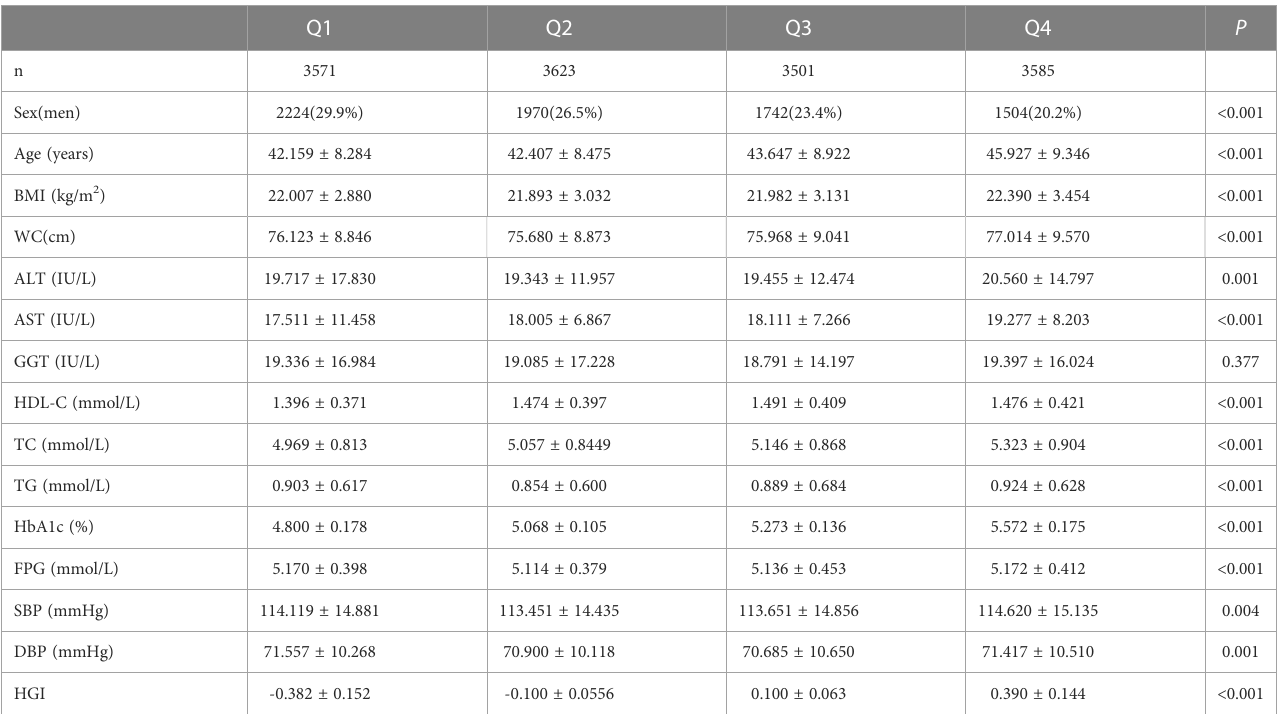
TABLE 2 Clinical Characteristics of subjects by HGI Category.